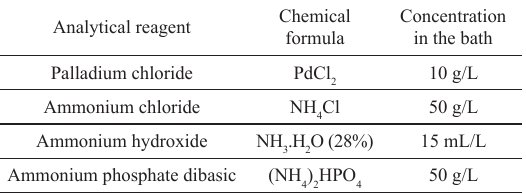
Table 2. Analytical reagents used for electroplating in the Pd